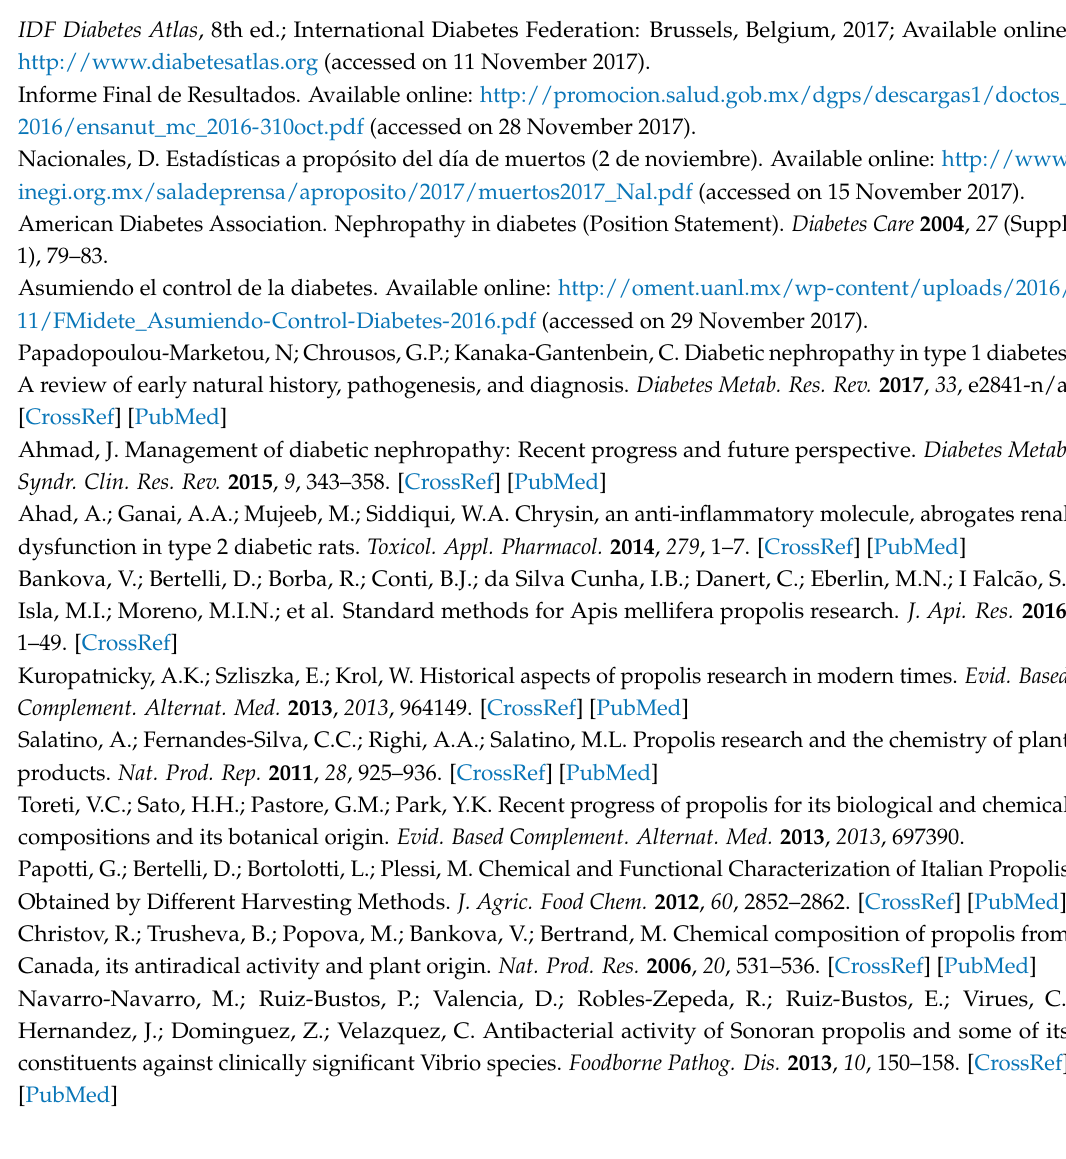
Figure S2: Flavonoids isolated from Mexican propolis. Table S1: 1 H-RMN data of the flavonoids isolated from Mexican